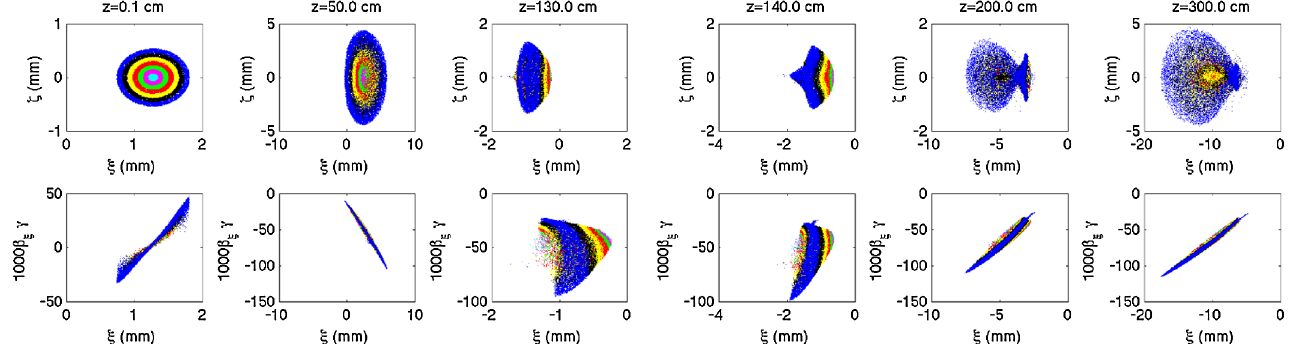
FIG. 12. (Color) Macroparticle distributions in the transverse configuration space (top) and transverse horizontal phase space (bottom) at different locations from the photocathode surface ( z ¼ 0 : 1 , 50, and 130, 140, 200, and 300 cm from left to right columns) associated in Fig. 7 (bottom row). The peak B-field of L3 is ^ B ¼ 0 : 376 T . The coordinate system is the Larmor frame to the peripheral beamlet b 1 ð (cid:10); (cid:11) Þ . The color coding corresponds to different radial slices at the emission time (the beam at emission was divided into seven radial slices of same thickness (cid:7)r ’ 70 (cid:1) m ).